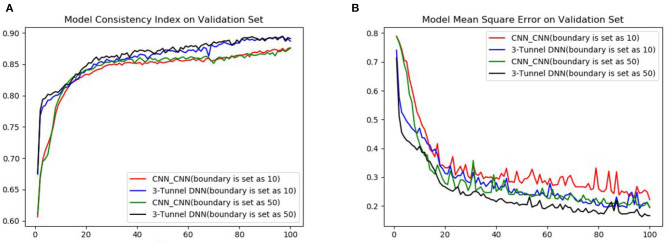
Comparison diagram of different boundaries in CNN_CNN model and MLP_CNN model. (A) Diagram of the accuracy on validation set and (B) diagram of the loss on validation set.